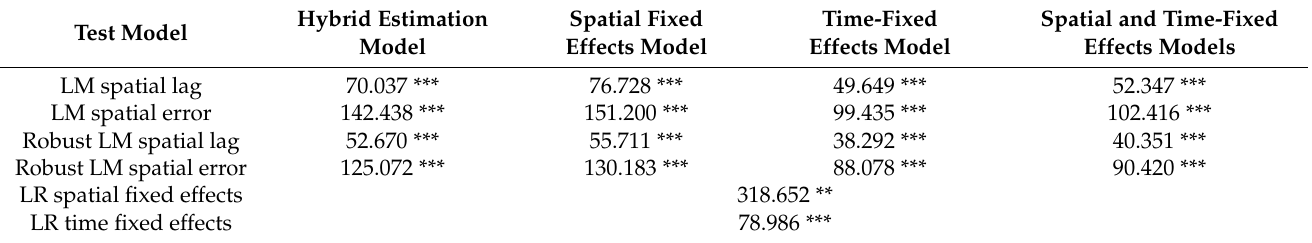
Table 4. Residual spatial correlation test of OLS estimation